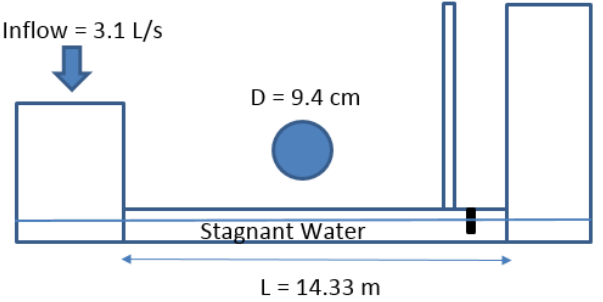
Figure 5. Schematic of test case 2.